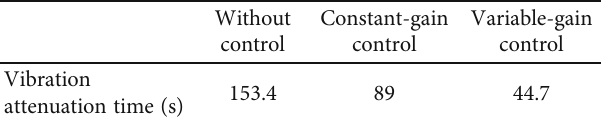
Without Constant-gain Variable-gain control control control